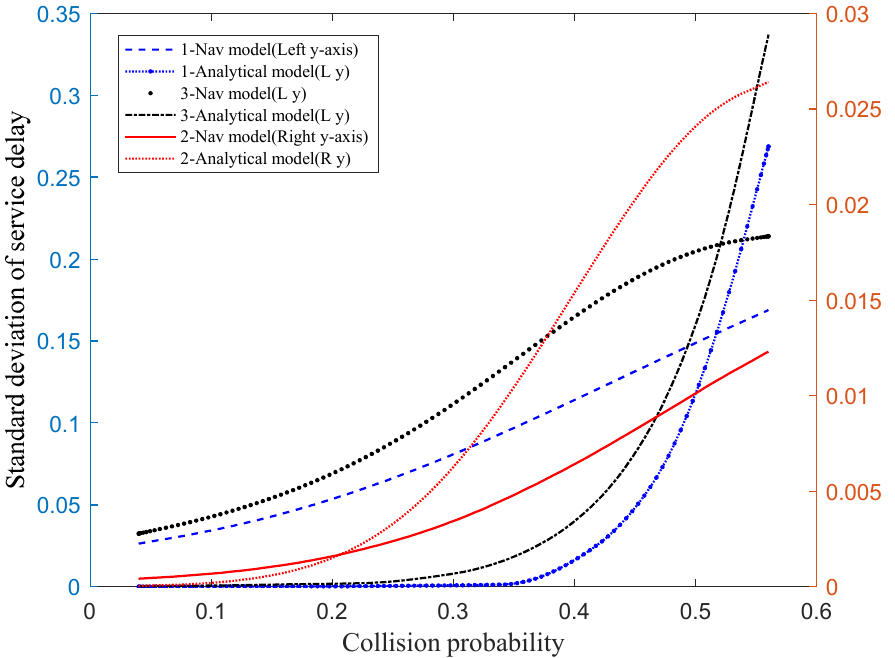
Figure 7. The standard deviation of the service delay in all scenarios.